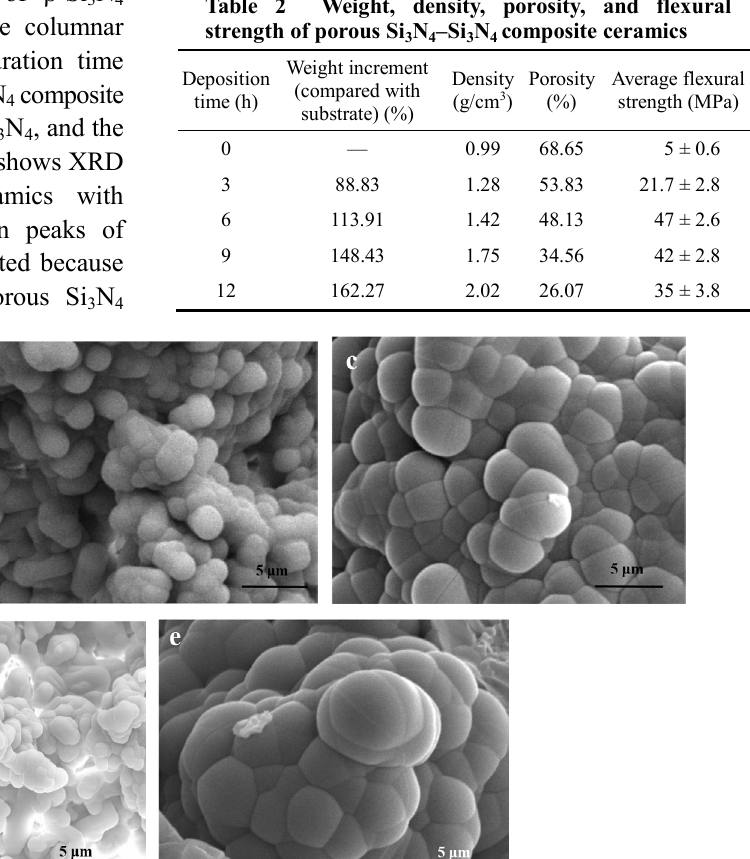
Weight, density, porosity, and flexural